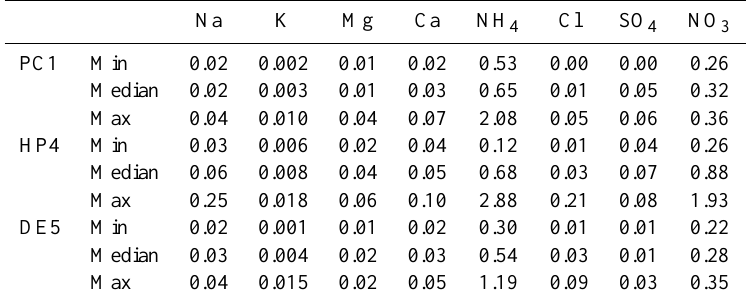
Table 2. Median, minimum and maximum concentration of individual cations and anions in streams [mmolL − 1 ]. NH 4 and NO 3 units are µmolL − 1